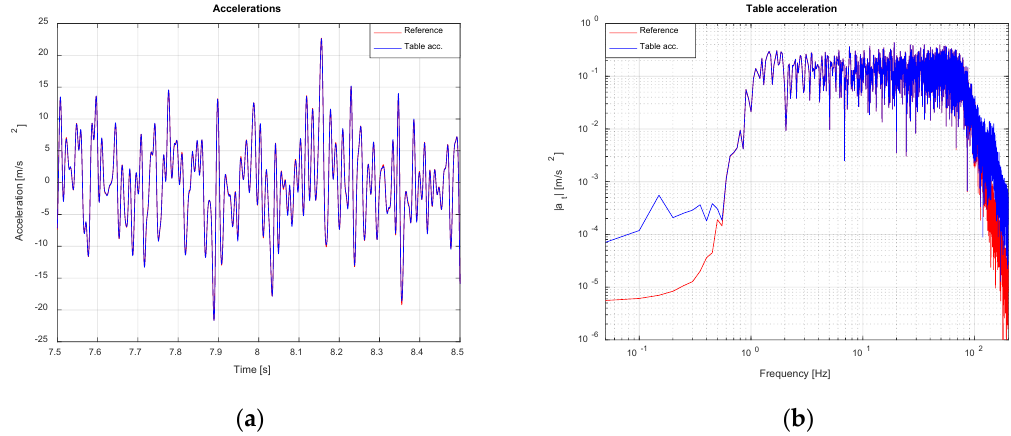
Figure 25. Shake table acceleration tracking (noise-contaminated scenario). TVC Enabled with improved parameters: ( a ) Time domain; ( b ) Frequency domain.